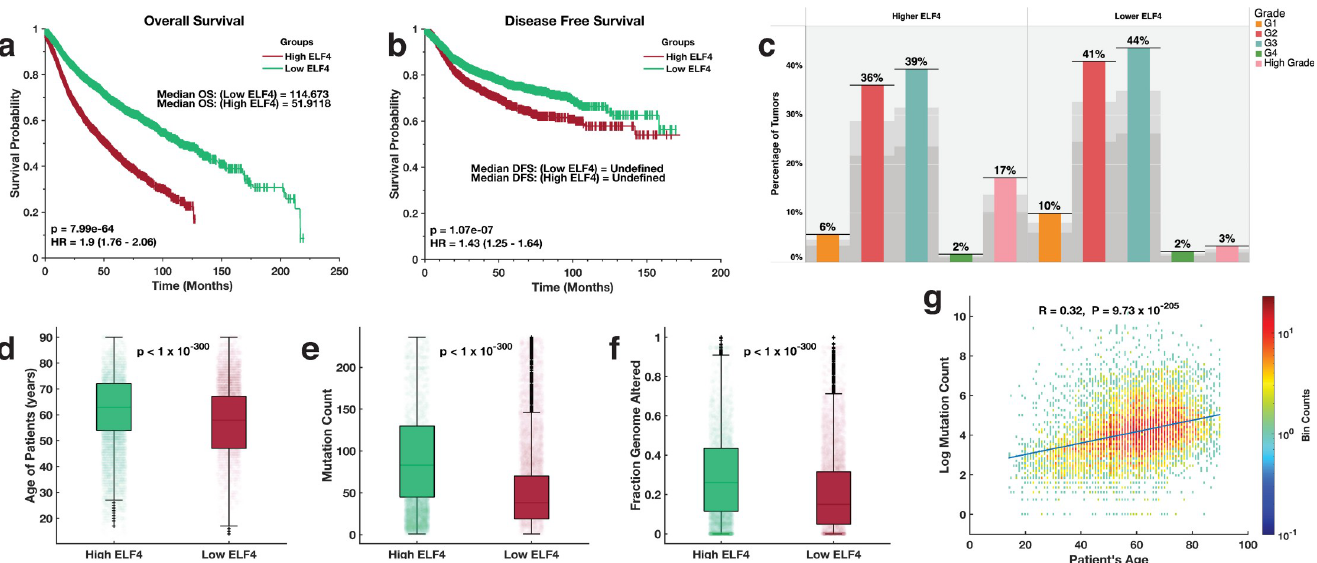
Fig 1. Kaplan-Meier curve of the overall survival periods (a) and disease-free survival periods (b) of TCGA patients with tumours that expressed high ELF4 and low ELF4 transcript levels. (c) the distribution of various grades tumours derived from 32 human cancer that expressed high ELF4 and low ELF4 transcript levels. Median comparison of the (d) age of the patients (e) number of mutations per patients’ tumours (f) the fraction of the genome altered for each patient tumour between the ELF4-high tumours and ELF4-low tumours. (g) binned scatter plot showing the Pearson’s linear correlation between the age of the patients and the number of mutations in each patient’s tumours. The data points spaced into rectangular bins and each point is coloured based on logarithm bin size with redder colours indicating a higher number of plots. The colour bar shows the colour scale.